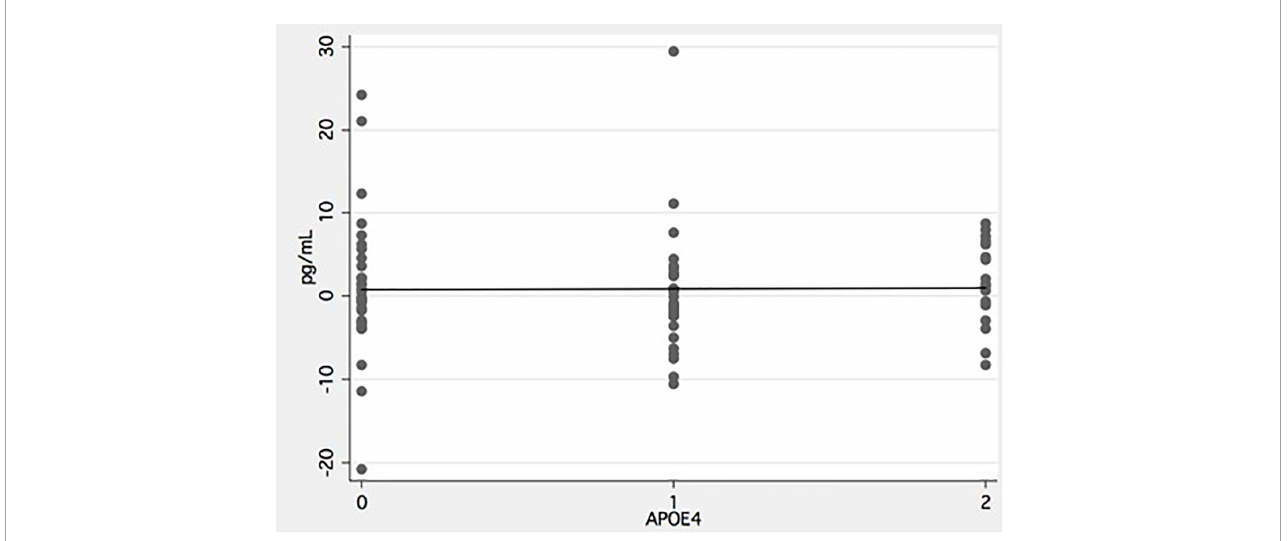
FIGURE3 Effect of number of APOE- ε 4 alleles on neurofilament light. X -axis indicate number of APOE- ε 4 alleles and y -axis change in serum concentration from baseline to follow-up in the intervention group. Negative values indicate a drop in serum NfL from baseline to follow-up.